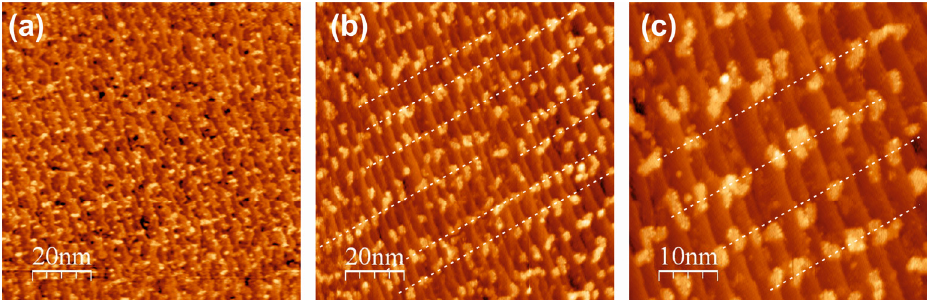
Figure 2. STM images of 0.14 ML Ce metal on Au(788), deposited at room temperature ( a ), and after postoxidation at 473 K in 5 × 10 − 7 mbar O 2 ( b , c ). ( a ) (100 × 100) nm 2 ; V S = 2.4 V; I T = 6.5 pA. ( b ) (100 × 100) nm 2 ; V S = 2.2 V; I T = 14.1 pA. ( c ) (50 × 50) nm 2 ; V S = 2.2 V; I T = 14.1 pA. The thin dashed lines in b,c are guides to the eye.